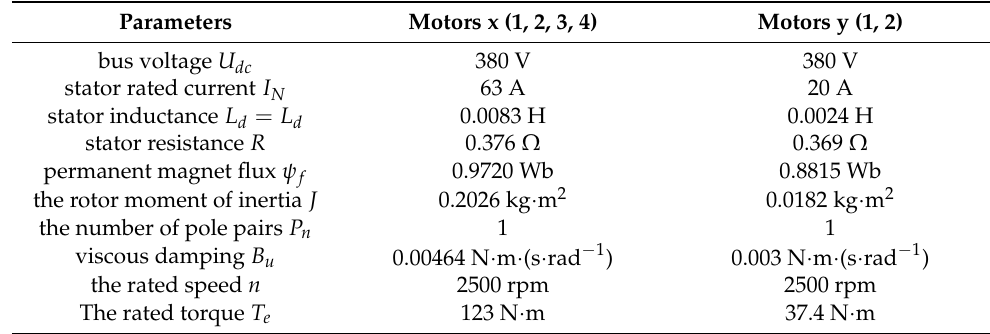
Table 1. Permanent-magnet synchronous motors parameters table. Parameters Motors x (1, 2, 3,